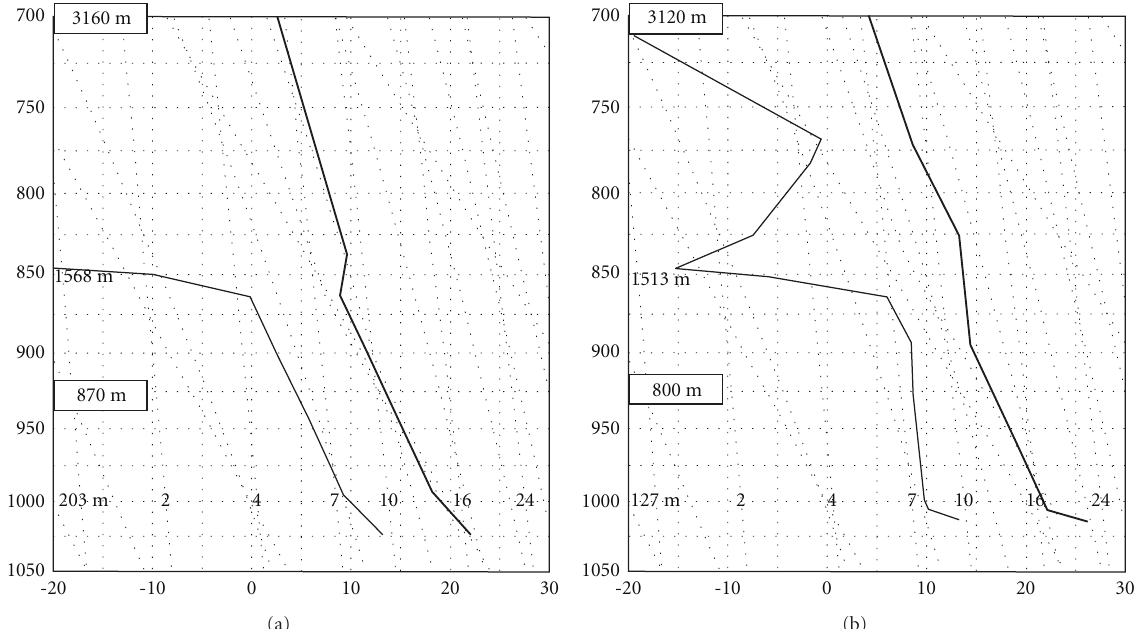
Figure 9: Tephigrams to 700 mb for Case 1 (a) and 2 (b). Thicker line represent Temperature and thinner line the dew-point temperature. Wind profile for each case is represented by wind arrows on the right side of each graph.